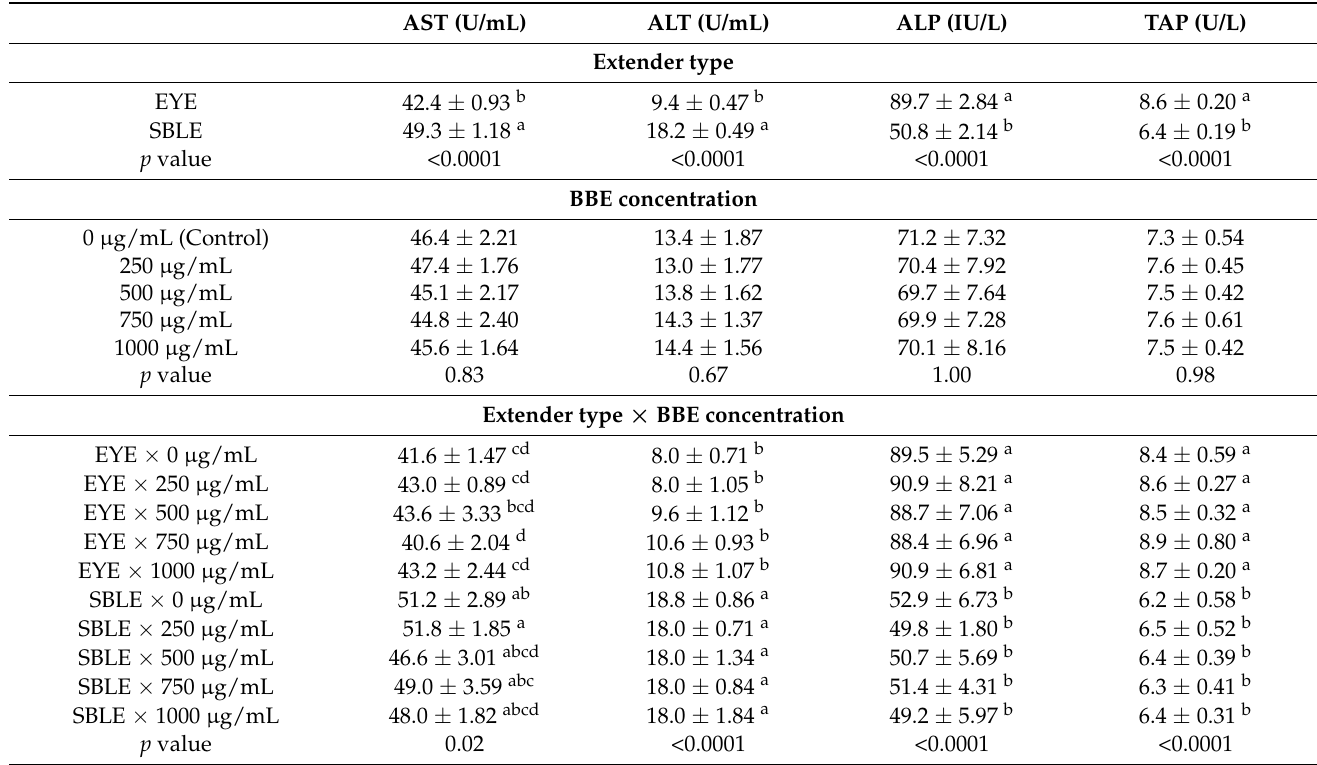
Table 6. Effects of the extender type, bee bread extract (BBE) concentration, and their interaction on enzymatic activities in the extender after thawing of ram semen. AST (U/mL) ALT